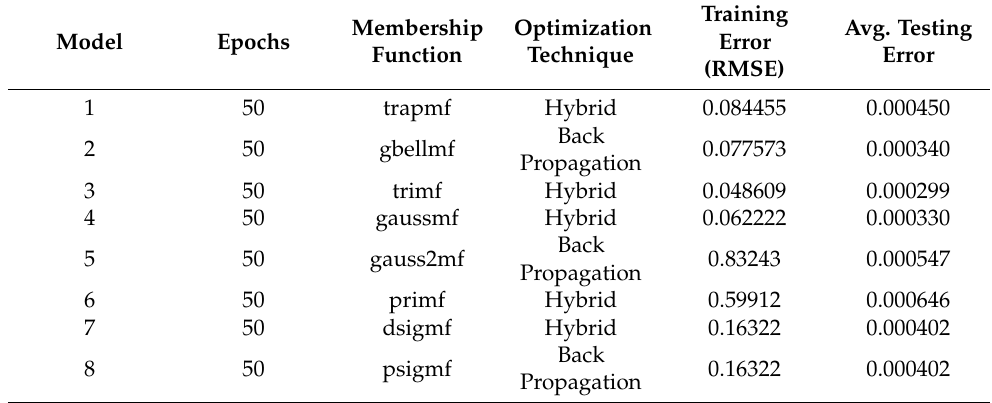
Table 11. Results from the ANFIS